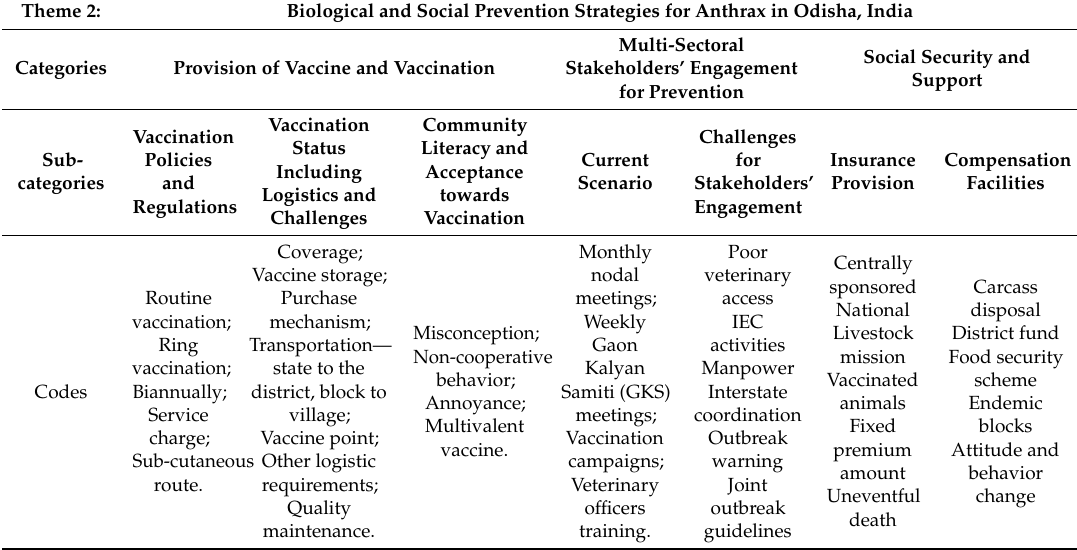
Table 3. Theme 2—Biological and social prevention strategies for anthrax in Odisha,